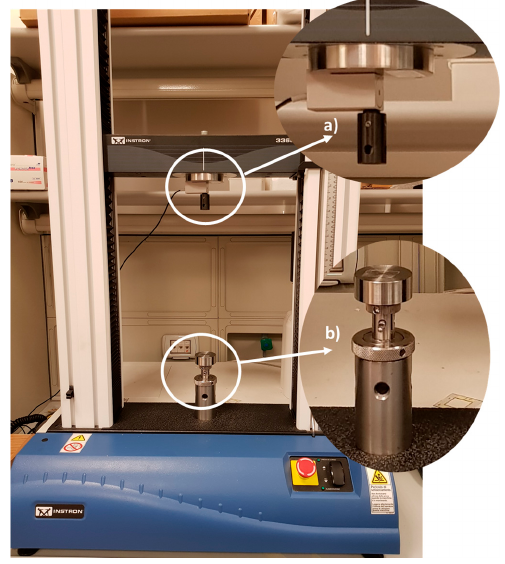
Figure 2. The traction/compression testing machine Instron 3365. With white circles are highlighted: ( a ) The load cell to which the probe is applied; ( b ) The flat support for sensor positioning.